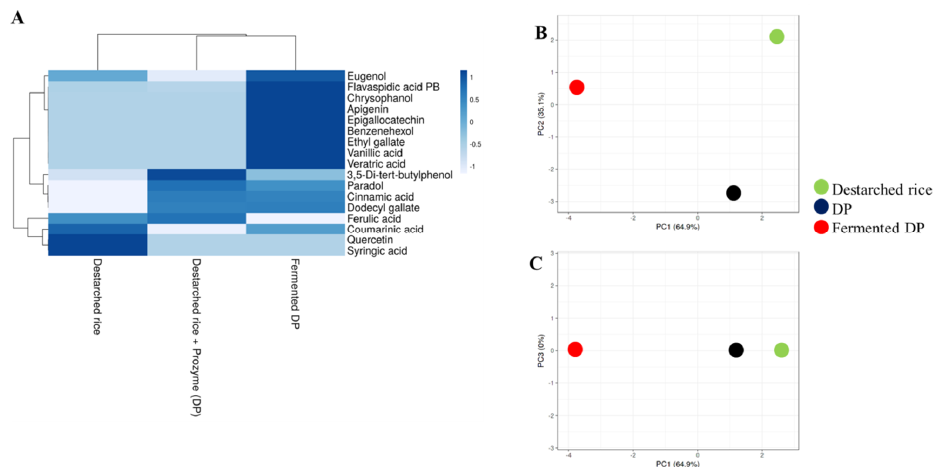
Figure 4. Relative levels of phenolic compounds in destarched rice, Prozyme treated destarched (DP), and fermented DP. ( A ) Heat map shows the different levels of phenolic compounds present in the three samples. The color range from blue to white represents higher to lower levels of phenolic compounds. ( B , C ) are principal component analysis (PCA) plots. ( B ) consists of PC1 and PC2, while ( C ) consists of PC1 and PC3. Red circles represent fermented DP, black represents Prozyme treated destarched rice (DP), and green represents destarched rice samples.